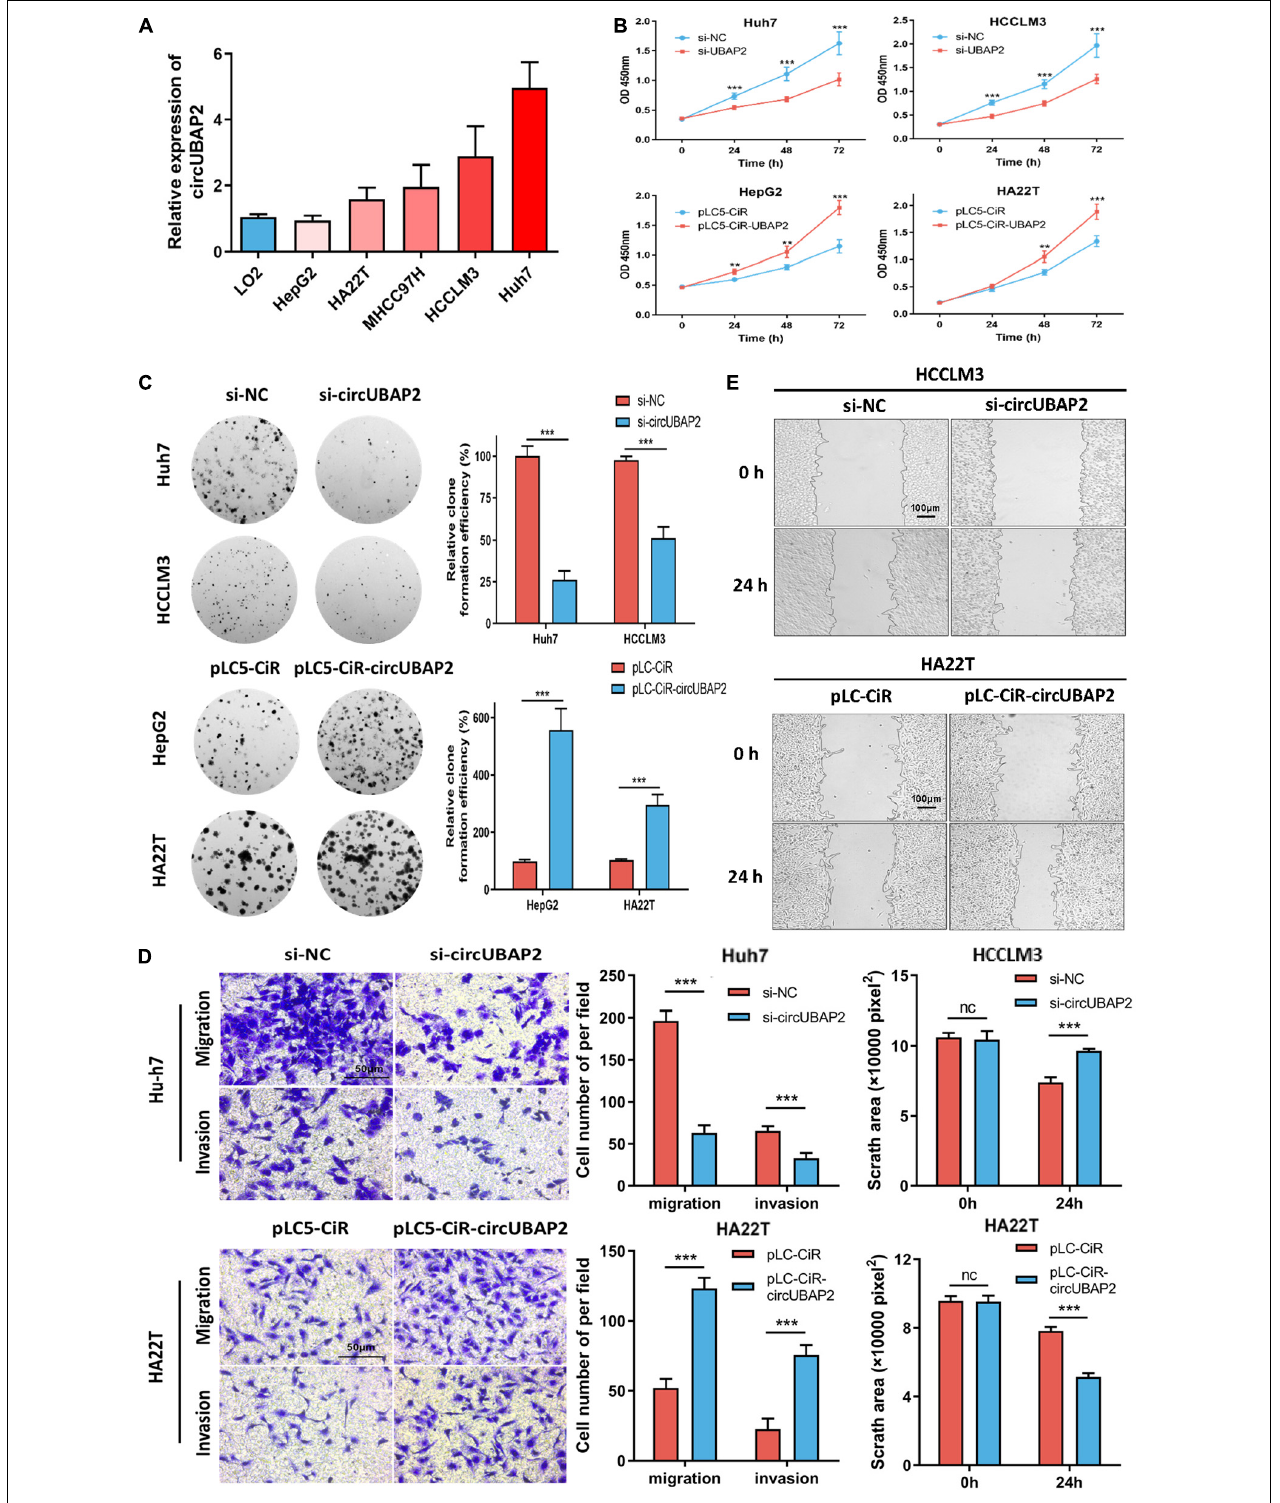
FIGURE 3 | CircUBAP2 promotes HCC proliferation, migration and invasion in vitro . (A) The expression levels of circUBAP2 in normal liver cell line and several HCC cell lines were analyzed by RT-qPCR. (B,C) CCK-8 and colony formation assays showed that circUBAP2 improved the proliferation of HCC cells. (D,E) Transwell (scale bar = 50 µ m) and wound-healing assays (scale bar = 100 µ m) showed that circUBAP2 promoted the migration and invasion of HCC cells. The black lines in (E) represent frontlines of the migrating cells. ns means P > 0.05, ** P > 0.01 and *** P > 0.001.